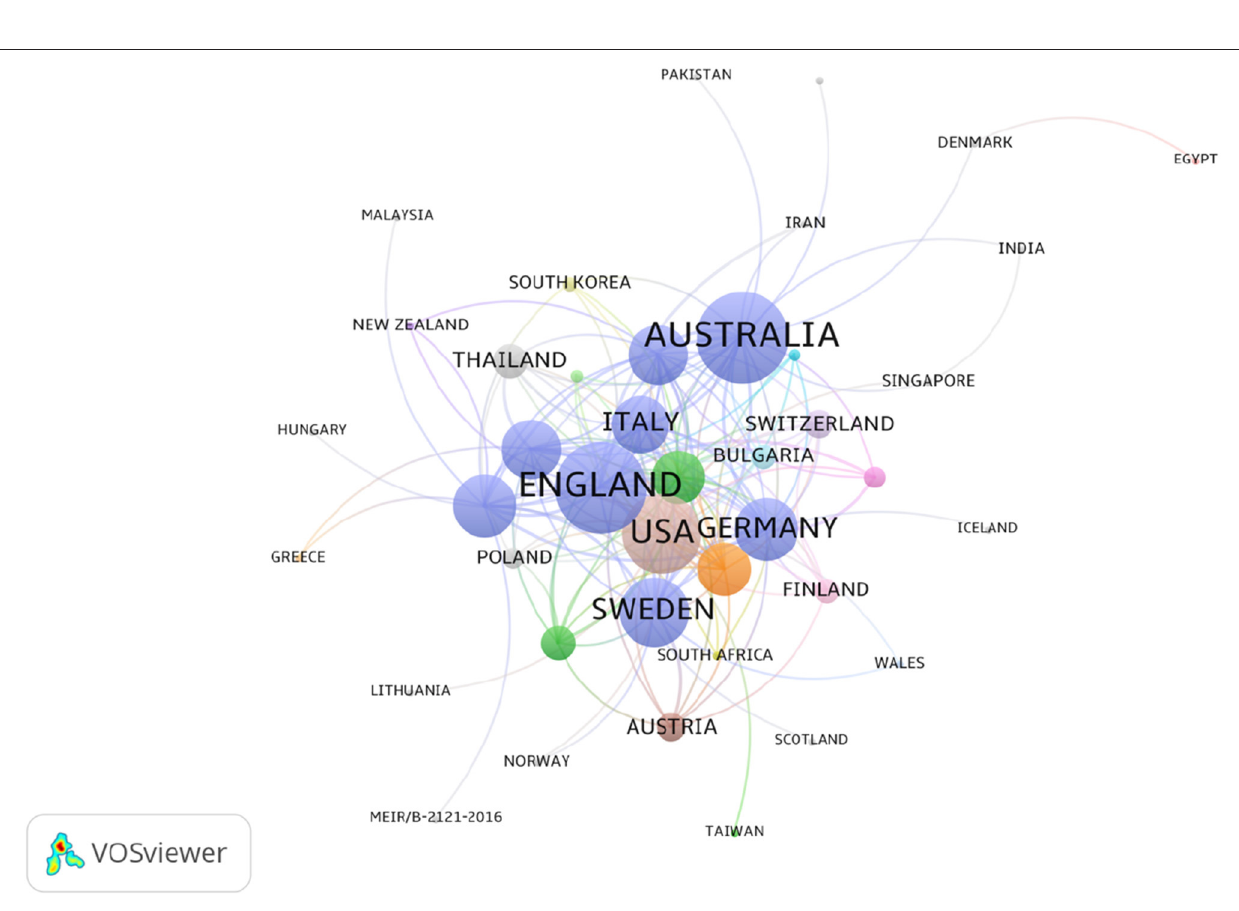
Frontiers in Public Health |